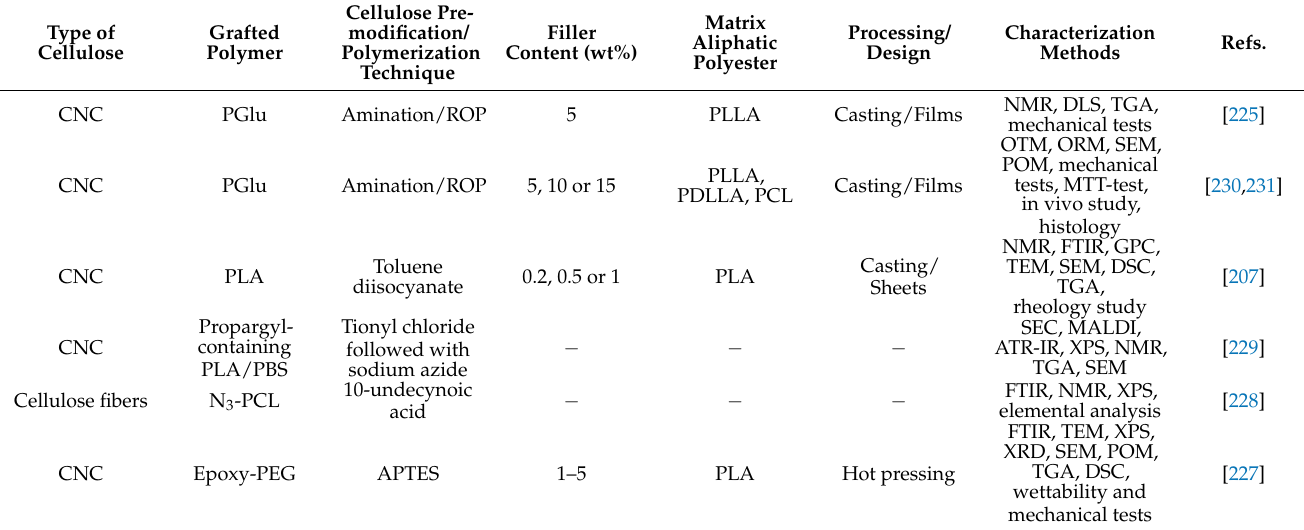
Table 9. Summary on covalent modification of cellulose micro- and nanomaterials by grafting “to”